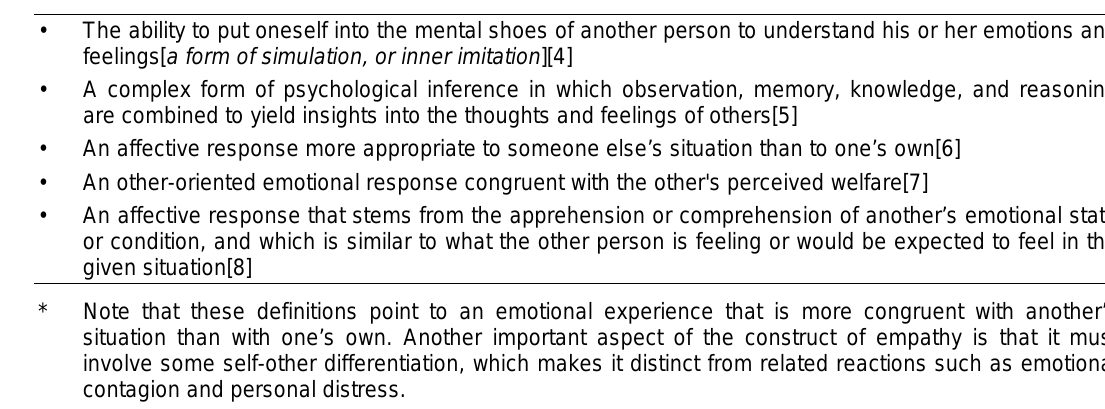
Various Definitions of